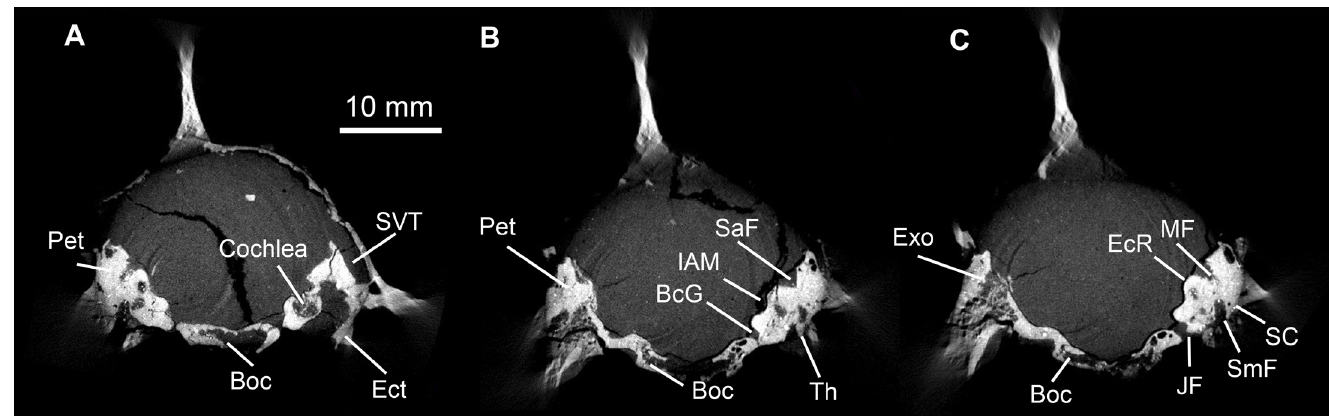
Figure 4. Transverse CT slices of SDSNH 47878. Higher numbered slices are located more rostrally. A, slice 101; B, slice 906; C, slice 875. Abbreviations: BcG, basicapsular groove; Boc, basioccipital; EcR, endocranial ridge; Ect, ectotympanic; Exo, exoccipital; IAM, internal acoustic meatus; JF, jugular foramen; MF, mastoid fossa; Pet, petrosal; SaF, subarcuate fossa; SmF, stylomastoid foramen; SC, semicircular canal; SVT, sinus venosus temporalis; Th,